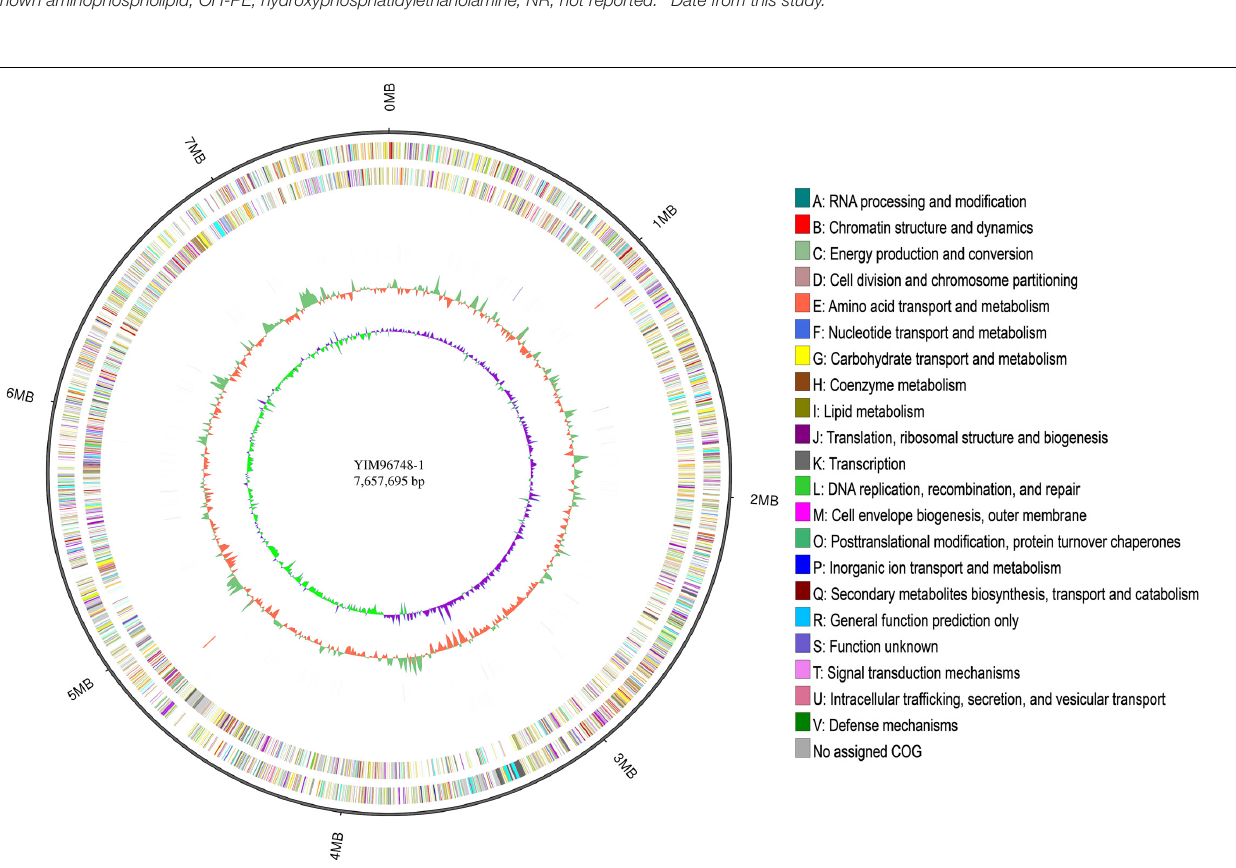
Frontiers in Microbiology |